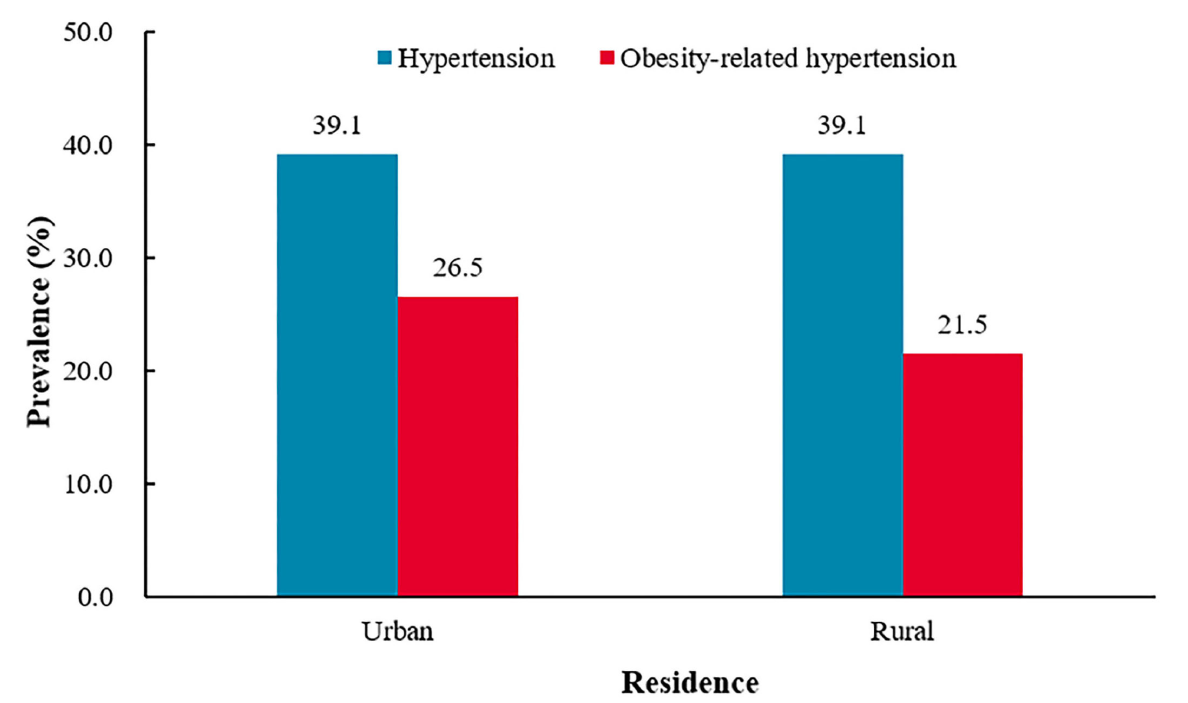
FIGURE3 The prevalence of hypertension and obesity-related hypertension among urban and rural areas. † P = 0.9802 for the difference in the prevalence of hypertension between urban and rural. ‡ P < 0.0001 for the difference in the prevalence of obesity-related hypertension between urban and rural.